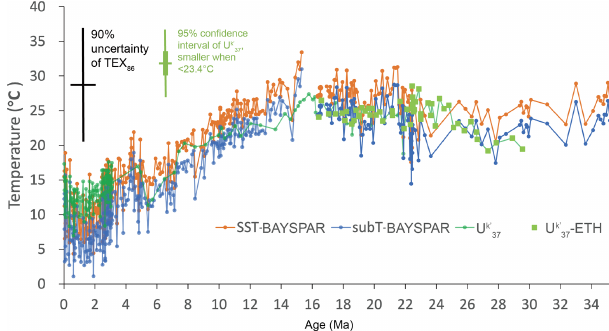
(cid:48) SST reconstructions of Site 1168. The Figure 4. TEX 86 and U k 37 BAYSPAR calibration (Tierney and Tingley, 2014) is used to trans- late TEX 86 values into surface (orange points) and subsurface (blue (cid:48) SST reconstruction (dark green) based on points) temperatures. U k 37 the BAYSPLINE calibration (Tierney and Tingley, 2018). All new (cid:48) SSTs of data are denoted by dots. Oligocene–early Miocene U k 37 Guitián and Stoll (2021) are represented by green